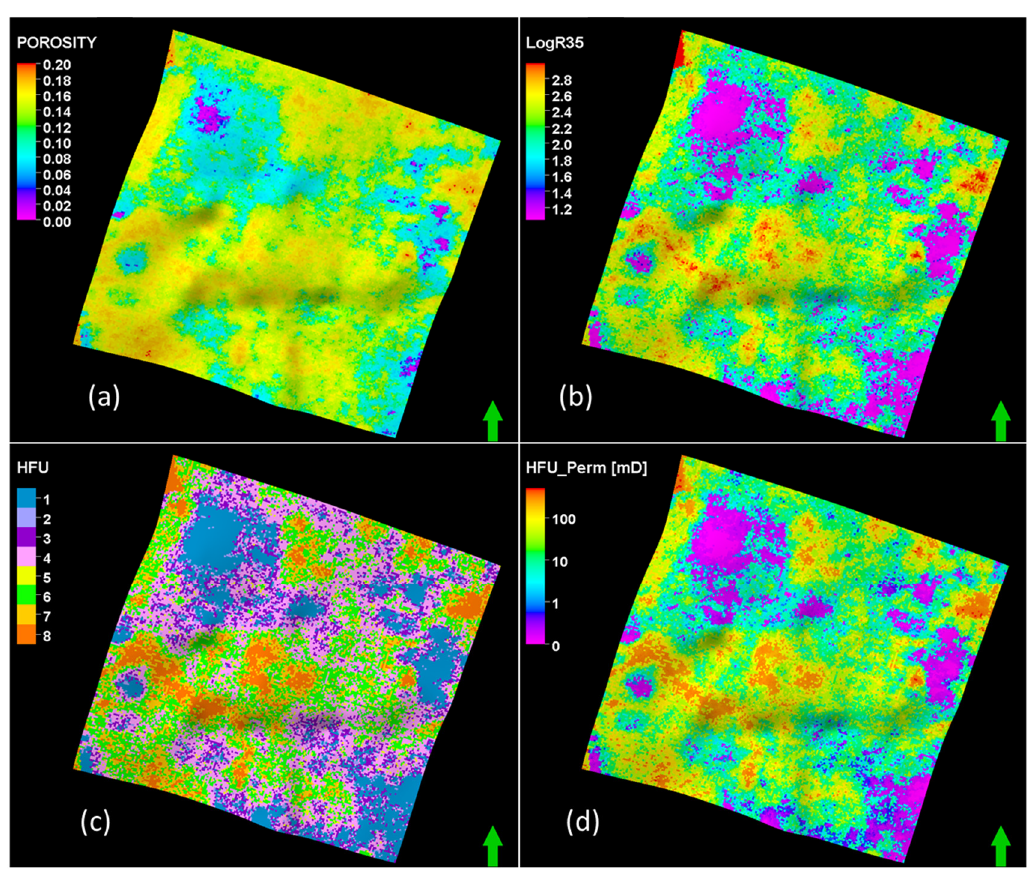
Figure 3. ( a ) Interpolated porosity logs, ( b ) R35 created by co-simulation of R35 logs with interpolated porosity, ( c ) HFU property created by applying R35 cut-offs, ( d ) Permeability created by application of HFU-specific poro-perm relation- ships.